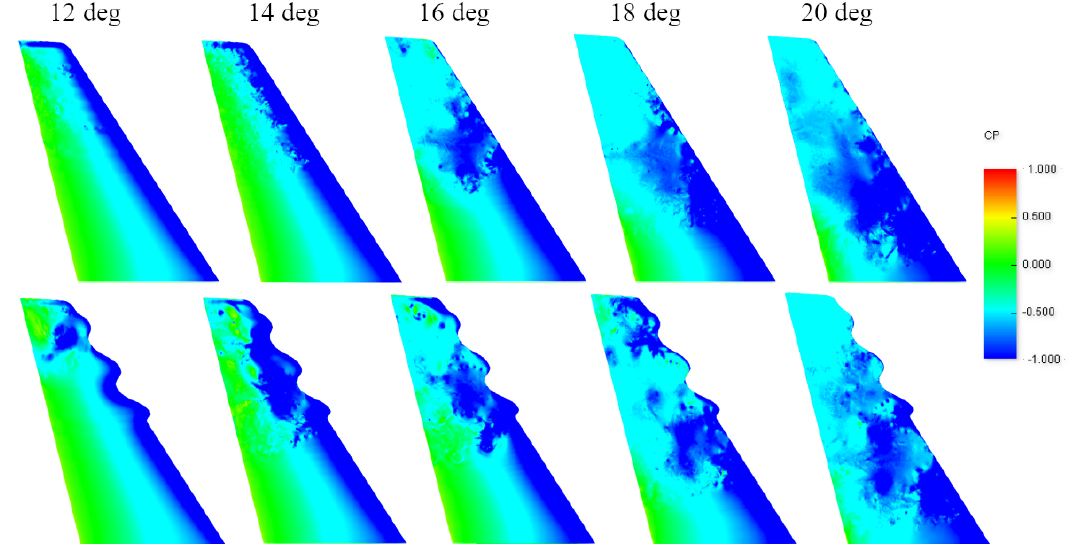
Figure 18. Surface pressure distribution for the baseline and A 10 λ 40 configuration geometry at 12, 14, 16, 18 and 20